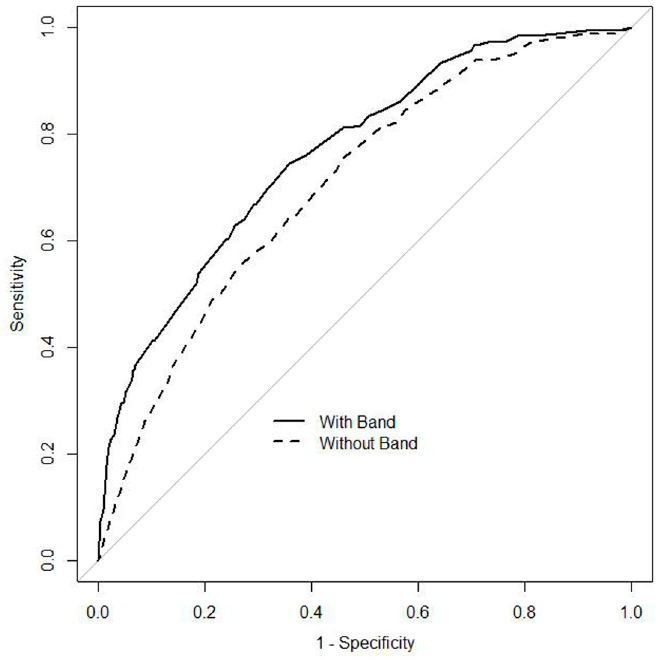
Figure 1. Receiver operating characteristic curves of multivariable logistic regression models for predicting bacteremia. The ‘With Band’ curve includes age, sex, body temperature, WBC count, eosinophil count, and band count percentage, while the ‘Without Band’ curve includes age, sex, body temperature, WBC count, and eosinophil count.